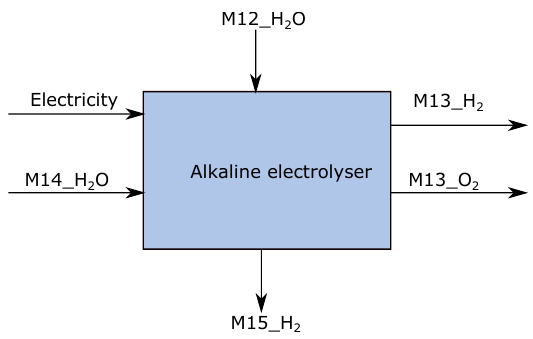
Figure 6. Mass and energy flow through the